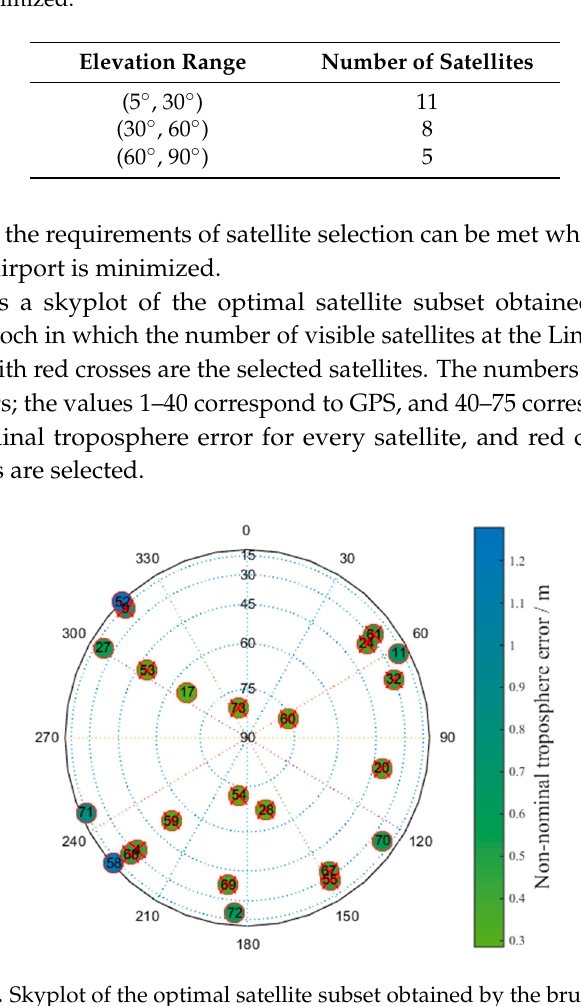
Figure 19. Skyplot of the optimal satellite subset obtained by the brute method.